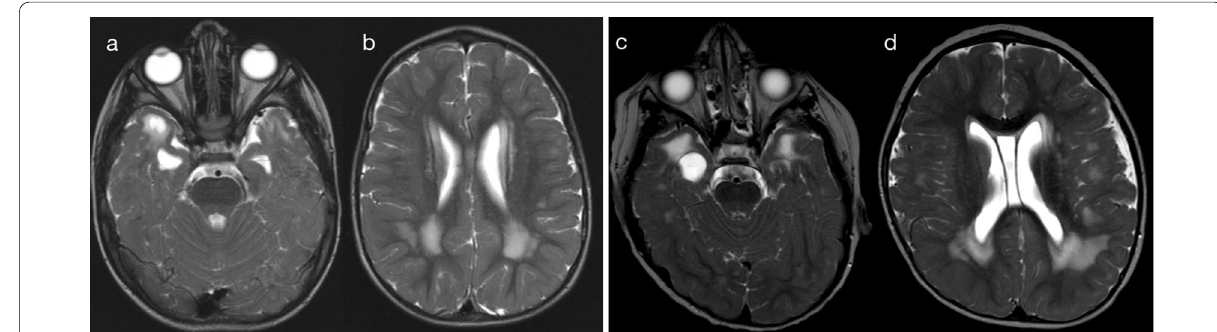
Fig. 13 T2 hyperintensity in supratentorial white matter—without neuronal migration abnormality (Pattern 4B). Case 1: 2‑year‑old child with congenital left sensorineural hearing loss. Guthrie test was positive for CMV. T2‑weighted imaging ( a , b ) demonstrated cystic change at the right anterior temporal pole, with bilateral parietal and periventricular white matter hyperintensity. Case 2: 2‑year‑old child with developmental delay. Guthrie test was positive for CMV. T2‑weighted imaging ( c , d ) demonstrated cystic change at the right anterior temporal pole, with bilateral peritrigonal white matter hyperintensity